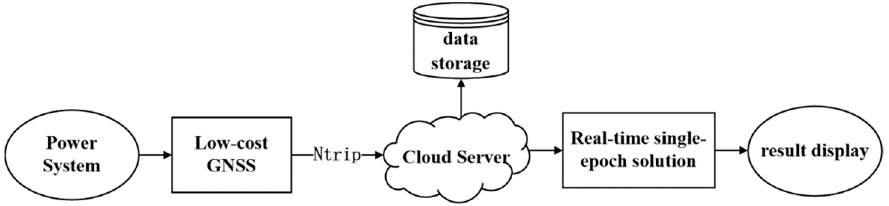
Figure 9. Brief technical route of the low-cost GNSS monitoring